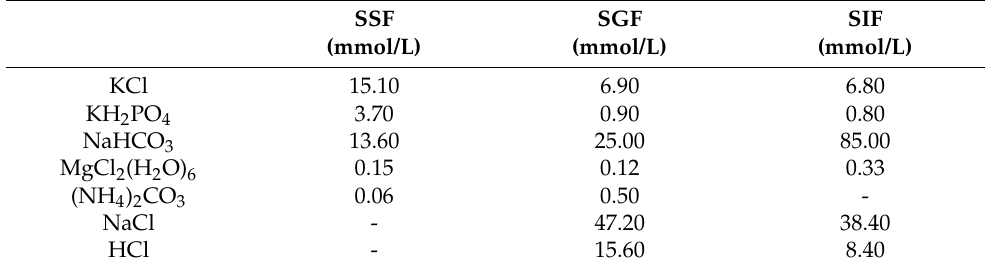
Table 1. Composition of electrolyte stock solutions: simulated salivary fluid (SSF), simulated gastric fluid (SGF), and simulated intestinal fluid